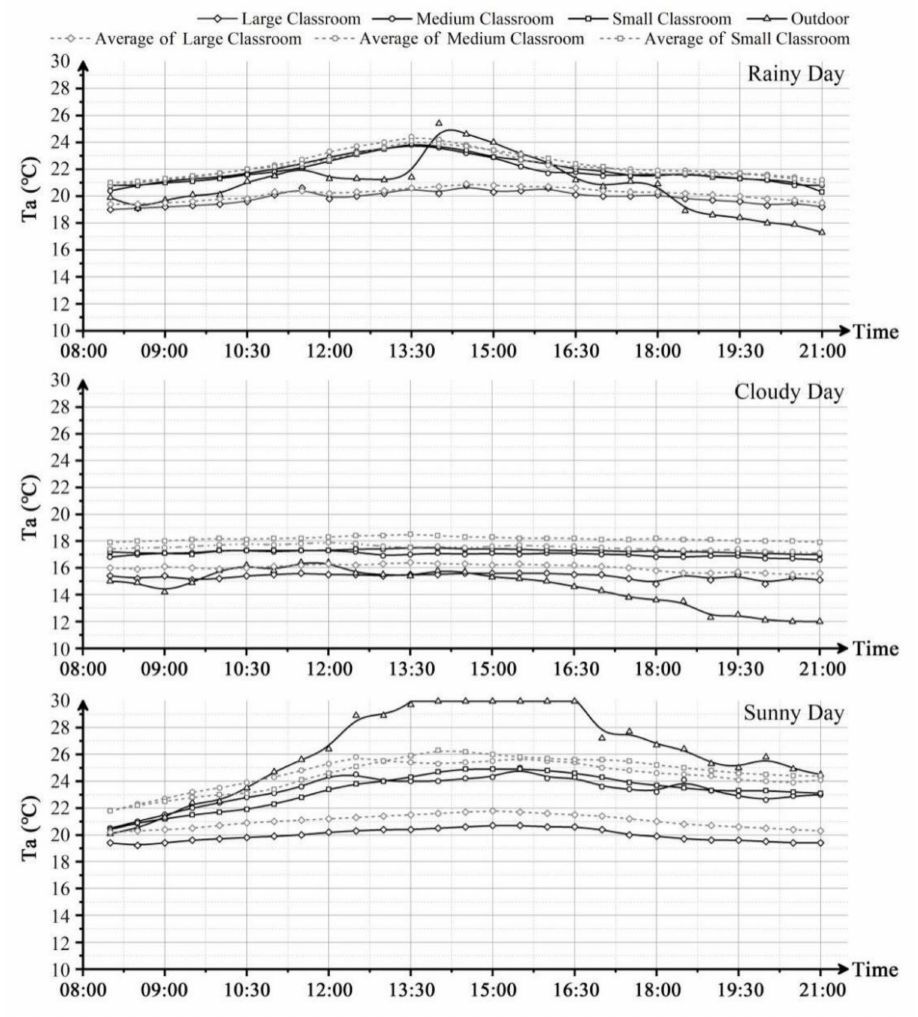
Figure 7. Temperature in the three classroom-types under different weather conditions throughout the